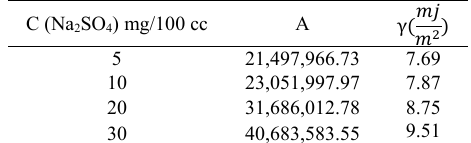
Table 4. Interfacial tension various concentration of Na